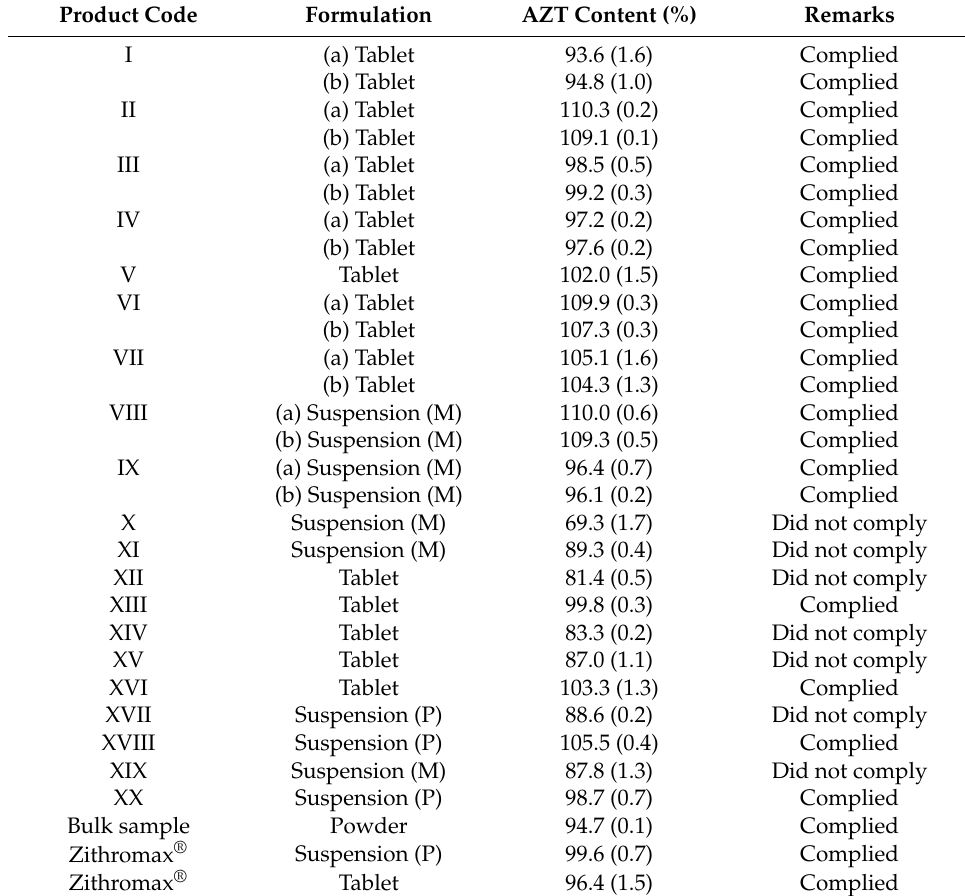
Table 3. Assay results for selected commercial samples of azithromycin. The figures in parentheses represent the coefficient of variation; P, Powder for reconstitution; M, Premixed; a and b represent different batches of each